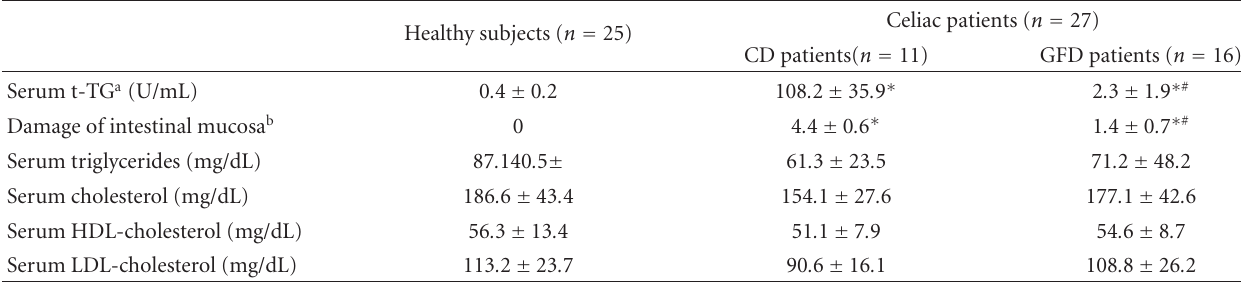
Table 1: Clinical characteristics and levels of serum lipids in healthy subjects, celiac patients at diagnosis (CD patients) and celiac patients treated with a gluten-free diet (GFD patients). Data are given as means ±